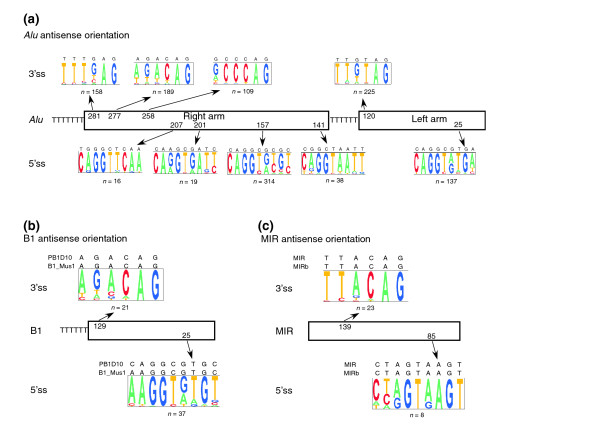
5' and 3' splice site selection of Alu, B1, and MIR. Both Alu and B1 originated from 7SL RNA. Alu has a dimeric form with a very similar left and right arm, whereas B1 has a monomeric form similar to the left arm of the Alu element. (a) The most selected 5'ss and 3'ss within the exonized Alu element in the antisense orientation. The right and left arm are shown by boxes. The numbers within the boxes indicate positions (according to the Alu consensus sequence) in which the prevalent 3'ss and 5'ss are selected, above and below the boxes, respectively. Pictogram depiction of each splice site is shown, the consensus sequence of Alu is marked above the pictogram, and the number of times that the site was selected is shown below it. (b and c) Similar presentation as in panel a for the prevalent 5'ss and 3'ss selected in B1 and mammalian interspersed repeat (MIR) elements, respectively.